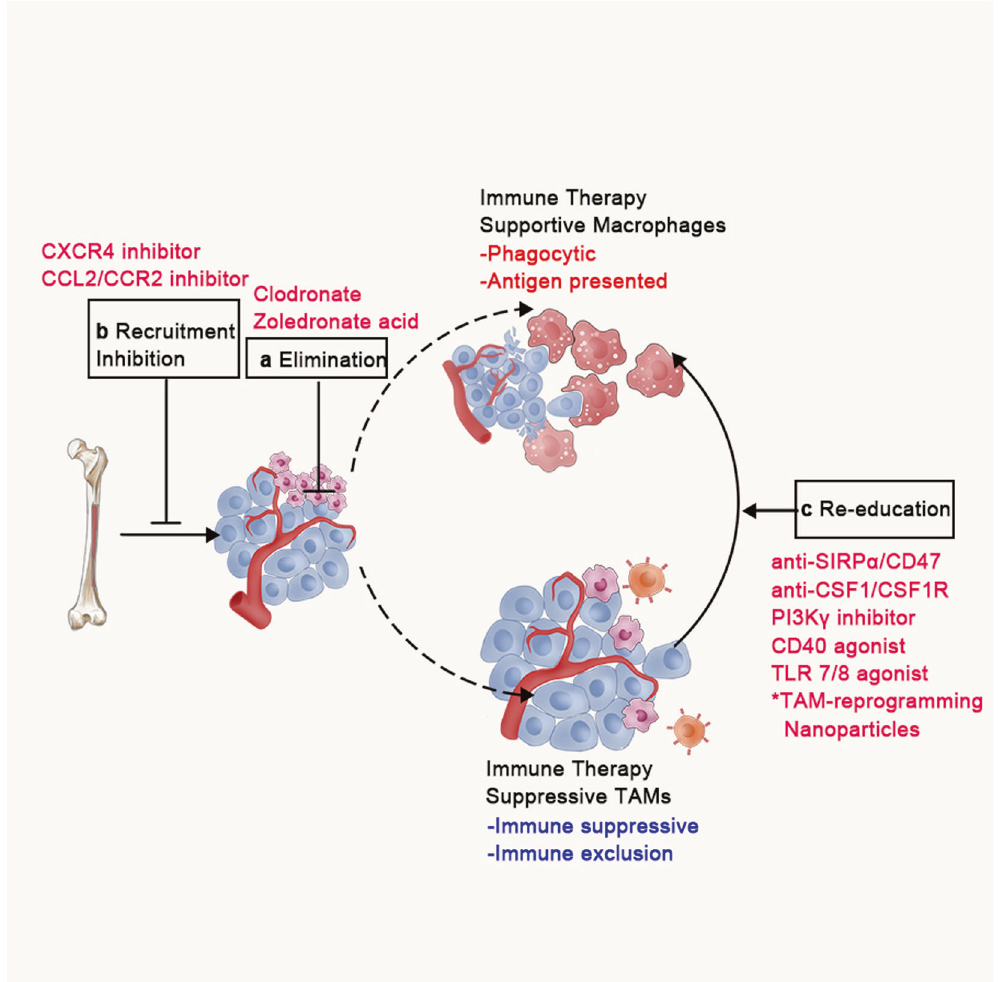
Fig. 3 TAM-targeted Strategies in Tumors. TAM-targeted strategies can be roughly divided as follows: a elimination of macrophages already present in tumor tissue; ( b ) inhibition of monocyte/macrophage recruitment; ( c ) reeducation of TAMs toward an “ immune-supportive